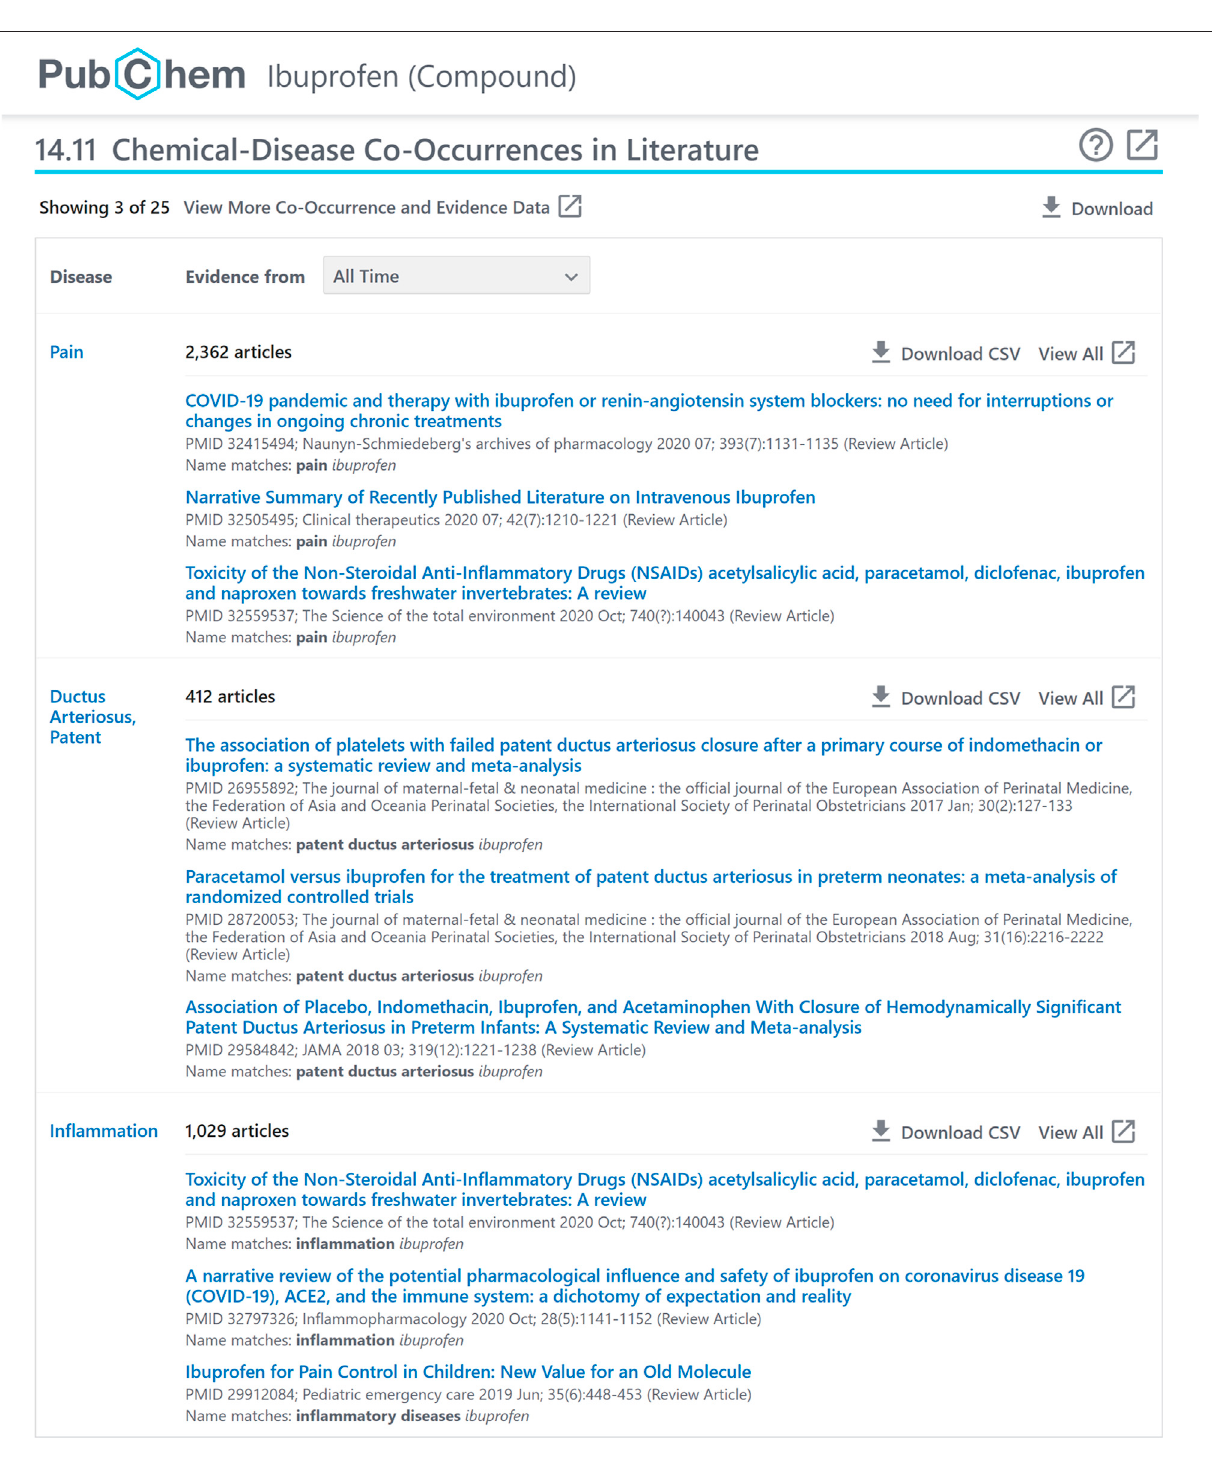
Frontiers in Research Metrics and Analytics |